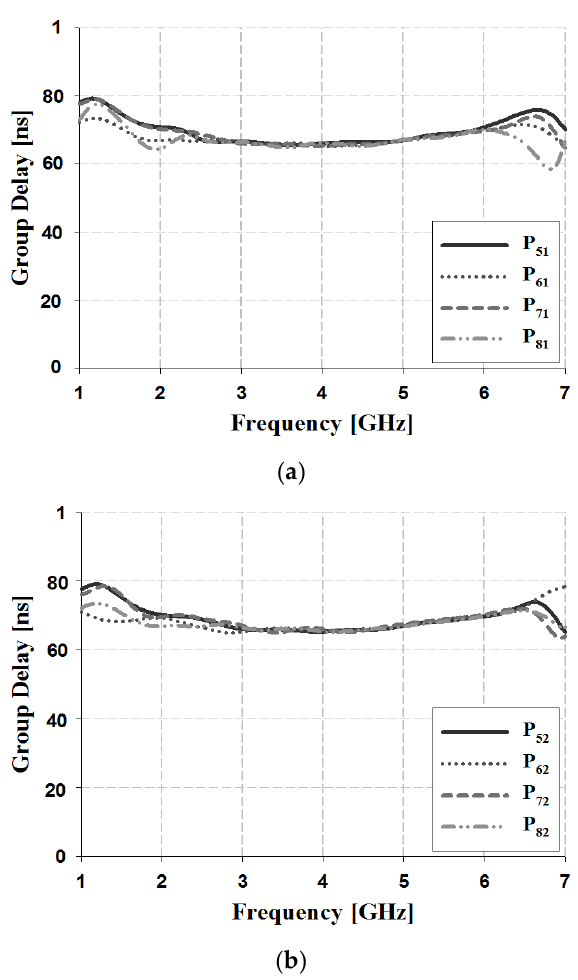
Figure 22. Group delay analysis of the proposed 4 × 4 Butler matrix ( a ) results of output ports for input Port 1, ( b ) results of output ports for input Port 2.